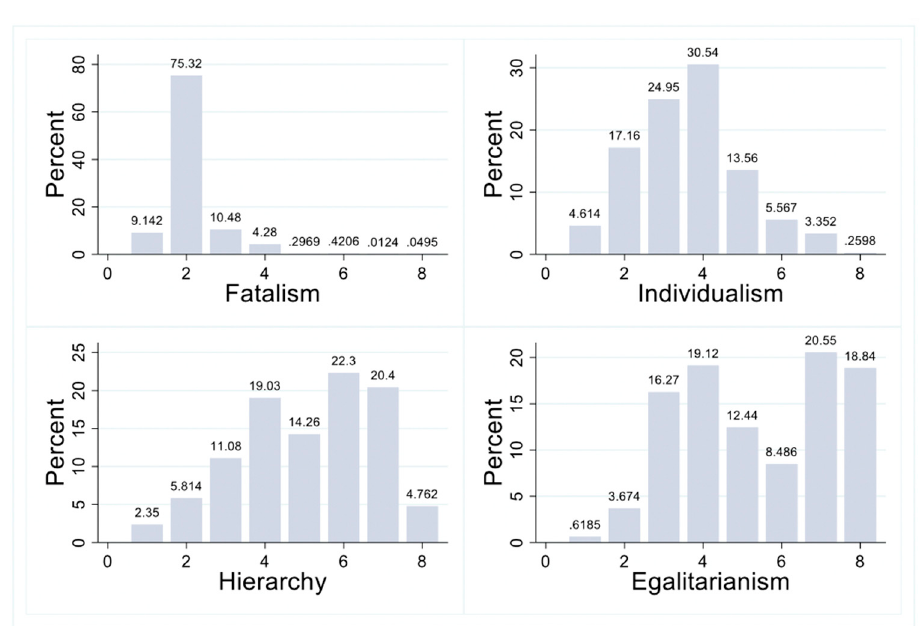
Figure 3. Distribution of Risk Cultural Biases (Average Frequency).